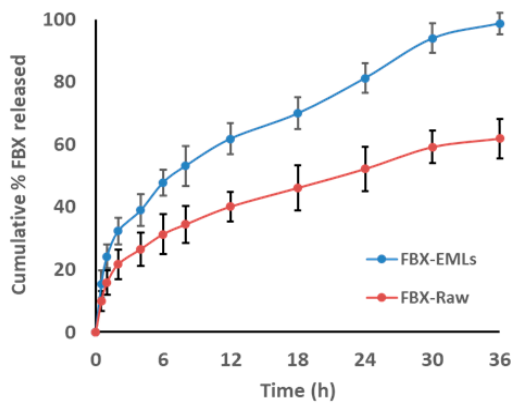
Figure 3. Optimized FBX-EMLs film in vitro release profile in comparison with FBX-R